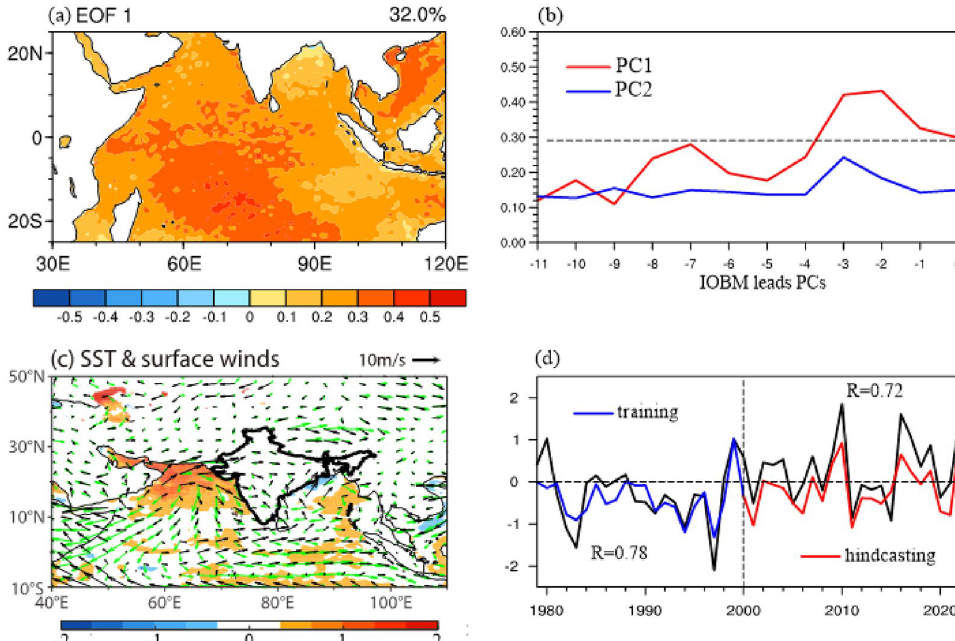
Fig. 4 a The spatial structure of the IOBM for the period of 1979–2022, calculated by the EOF function of monthly SST anomalies obtained from ERSST. b The lead correlation coefficient of the monthly IOBMI with the April PC1 (red line) and PC2 (blue line) during the period of 1979–2022. The zero of x-axis represents the concurrent correlation. c Regression of April SST anomalies with the January IOBMI (colors; °C). The green and black vectors are the mean surface winds during March and April (m/s). d The normalized SATI (black line; the same as the blue line in Fig. 1c), the predicted SATI for the training period (blue line; 1979–2000) and the hindcasting period (red line;